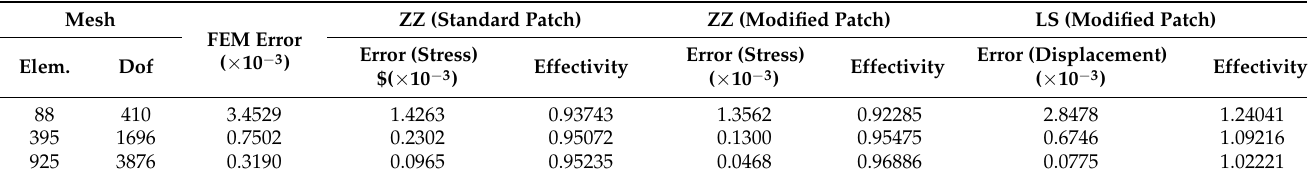
Table 4. Solution error and global effectivity for the plate problem using stress/displacement recovery and patch configura- tion (irregular quadratic triangular element).